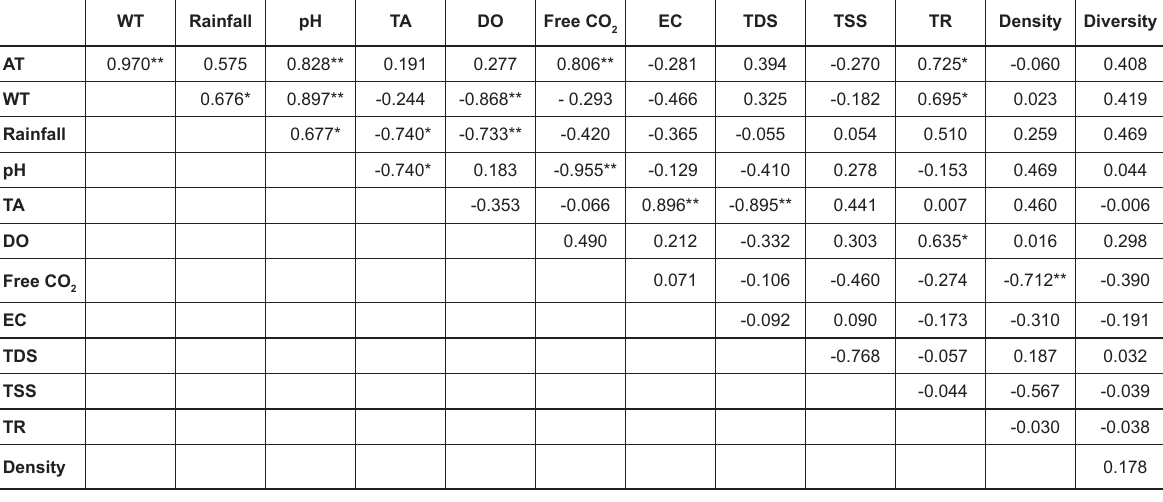
Table 4. Correlation coefficient matrix of environmental variables, diversity, and density of Hemiptera in the pond